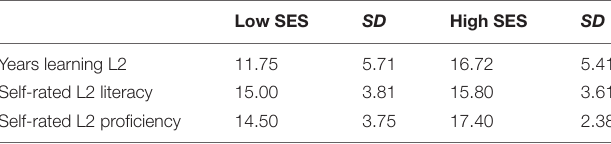
TABLE 1 | Bilingual participants’ language history